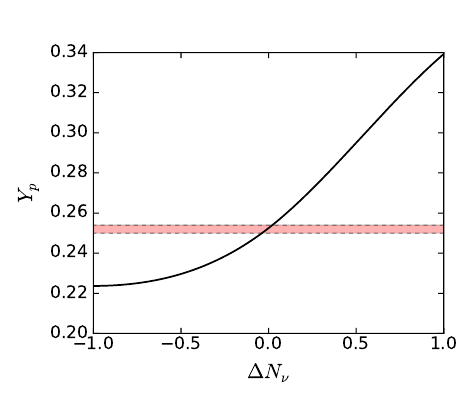
Figure 6: Predictions for the primordial 4 He mass fraction as a function of extra neutrino families, N ν = 3 + ∆ N ν , with T (cid:48) = 0 . 3 T BBN and N DM = 5. The horizontal band represents the observed mass fraction [64].